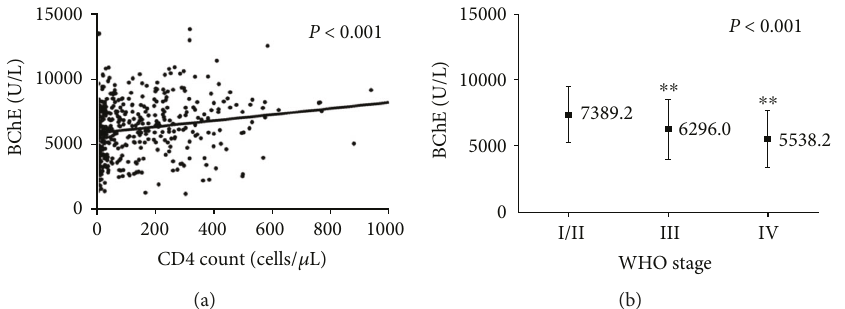
Figure 2: BChE is associated with HIV/AIDS progression. (a). BChE level is correlated with CD4 count ( P < 0 001 ). (b). BChE level is negatively associated with HIV/AIDS stage ( P < 0 001 ). ∗∗ P < 0 01 using one-way ANOVA test.